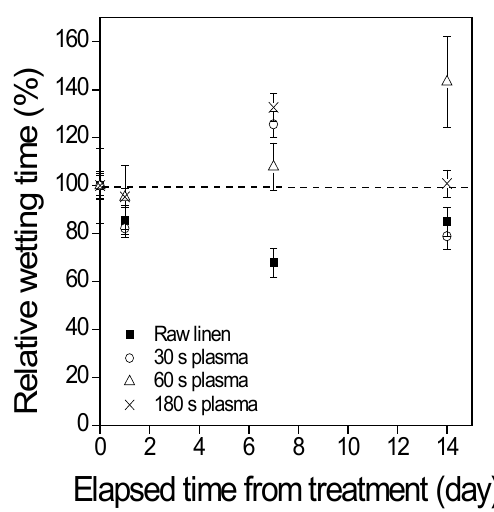
Figure 3: Relative wetting time versus time elapsed after plasma treatment of linen